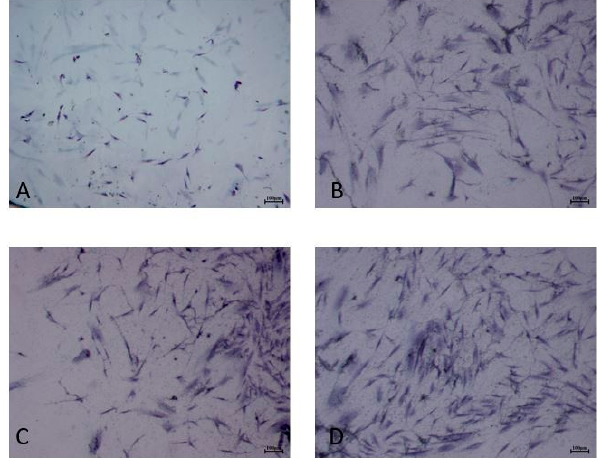
Figure 3. Cell staining. HOB were subjected to ALAD-PDT protocol and stained after 24 h with toluidine blue. ( A ) CTRL, ( B ) 0-ALAD-PDT, ( C ) 100-ALAD, ( D ) 100-ALAD-PDT.